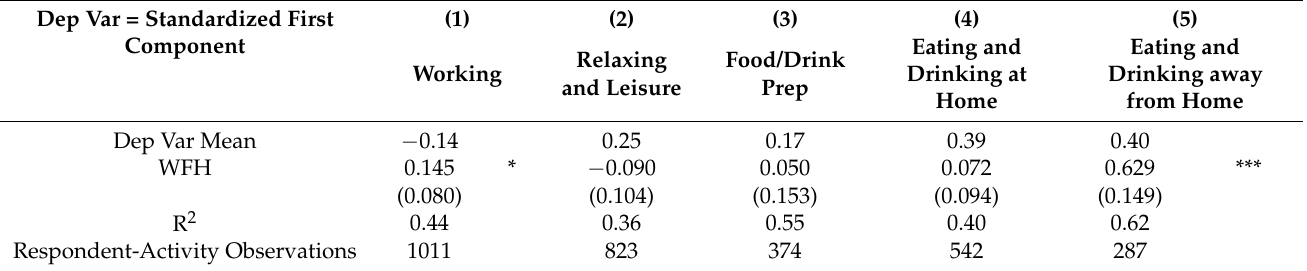
Table 2. Coefficients and standard errors from seemingly unrelated regressions of overall emotional well-being during major activities on WFH status and other worker